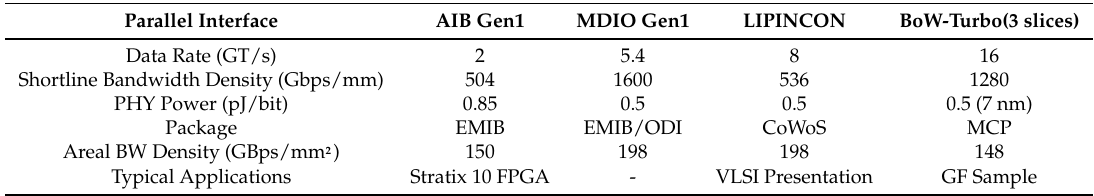
Table 3. Comparisons among parallel interfaces of chiplets at the physical layer